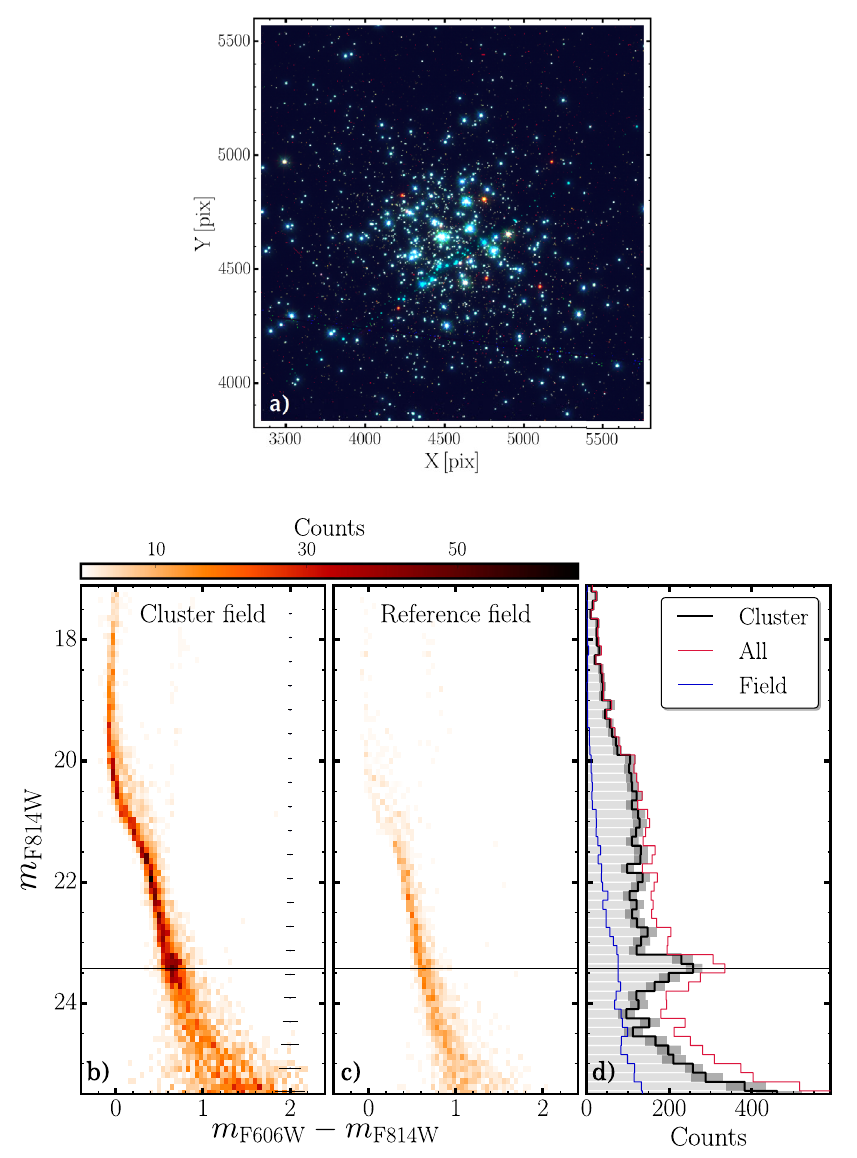
Fig. 1 | Hubble Space Telescope view of NGC 1818 and its colour – magnitude diagram. a Three-colour image of a portion of the analysed Hubble Space Tele- scope fi eld around the centre of NGC1818. The pixel scale is 0.04arcsec/pix. b , c Colour – magnitude diagram of cluster- fi eld and reference- fi eld stars, respectively. The top colourbar indicates stellar counts. Photometric uncertain- ties, inferred from arti fi cial star tests as discussed in the ‘ Methods ’ section,